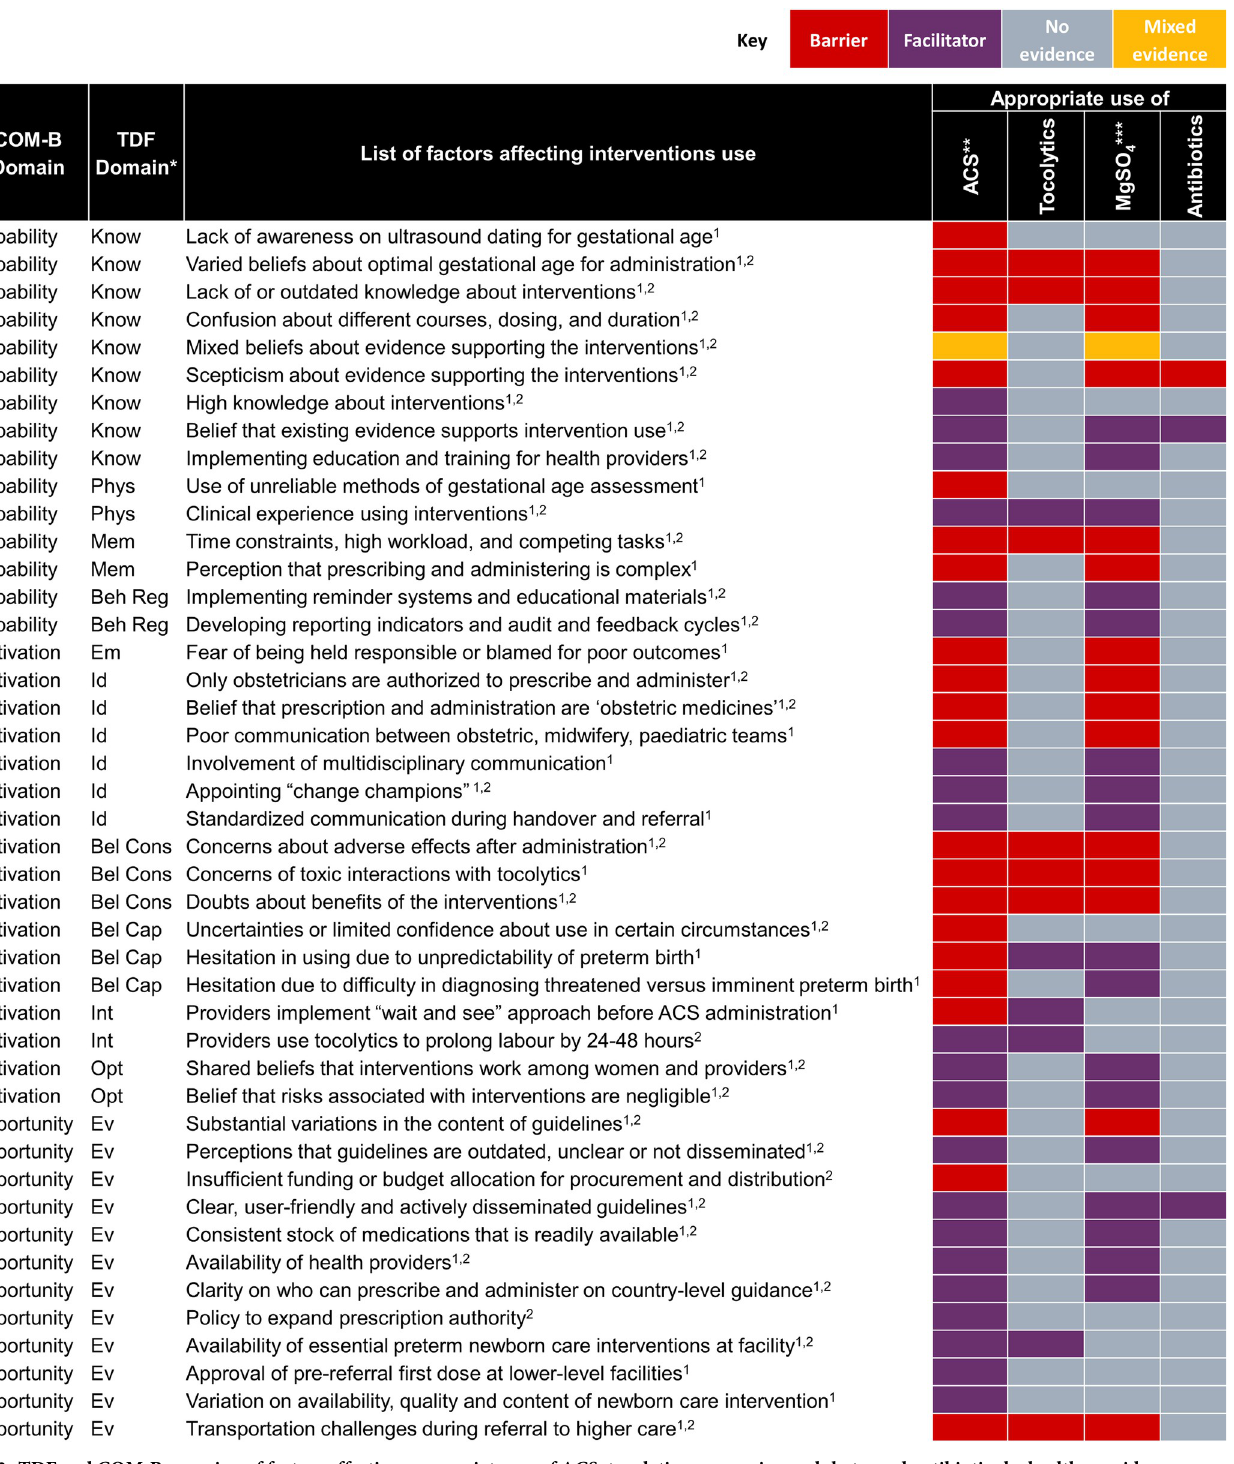
PLOS Medicine| https://doi.org/10.1371/journal.pmed.1004074 August 23,